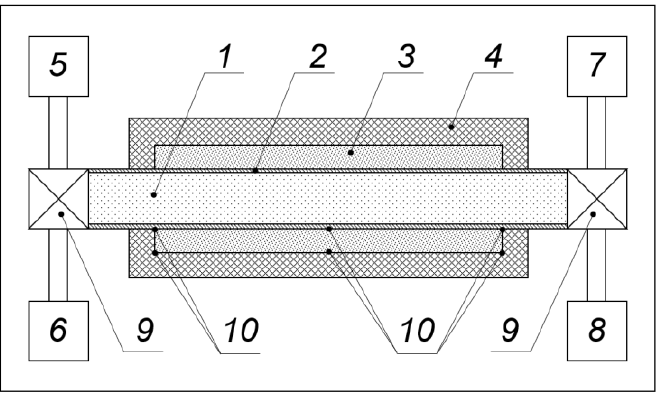
Figure 2. Schematic representation of a WTA module. 1—cylindrical tube of outer radius R 1 and wall thickness of d 1 for passage of hot or cool water; 2—copper envelope of the inner cylinder; 3—space between the inner and outer cylinder filled with PCM; 4—plastic envelope of inner radius R 2 and of d 2 in thickness of the outer cylinder; 5—cold water input; 6—hot water input; 7—hot water output; 8—cold water output; 9—water supply taps; 10—thermocouples.